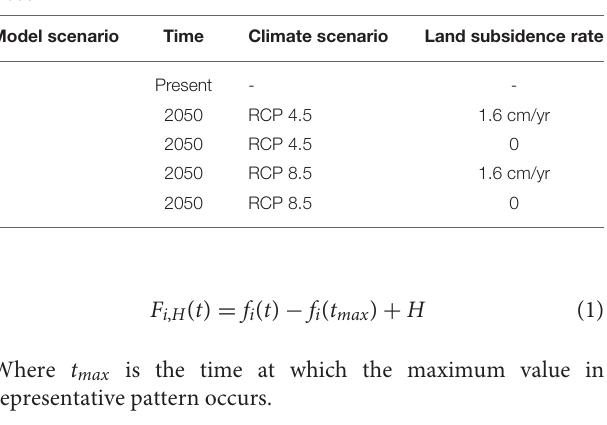
TABLE 2 | Model scenarios adopted with the 1D/2D coupled flood PCSWMM